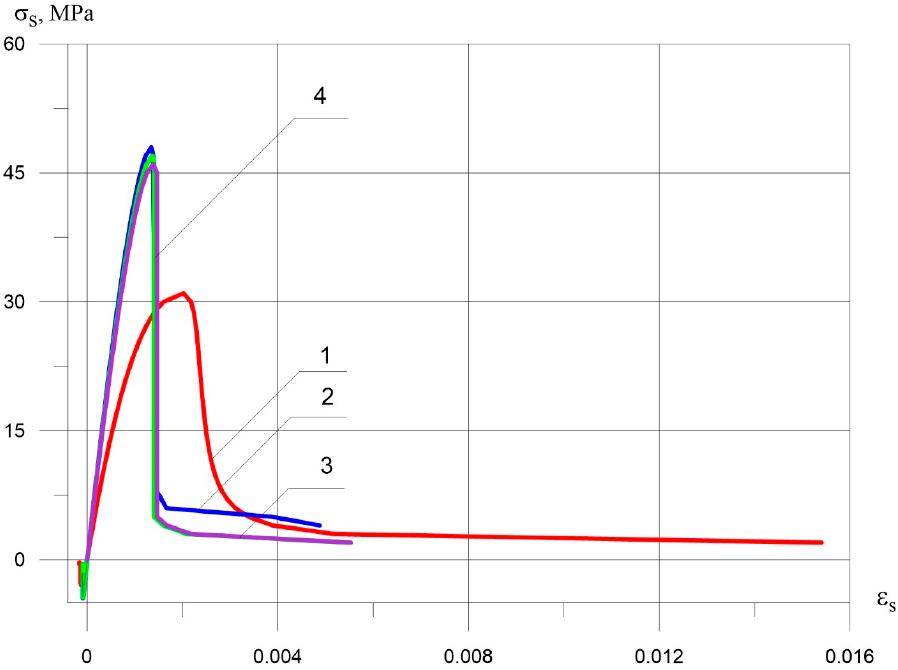
Figure 15. Dependencies of the concrete deformation: 1—control composition; 2—concrete with a volume content of steel fiber 2% and basalt 2%; 3—concrete with a volume content of polypropylene fiber 1.5% and basalt 2.5%; 4—concrete with a volume content of steel fiber 2.5% and polypropylene 1.5%.